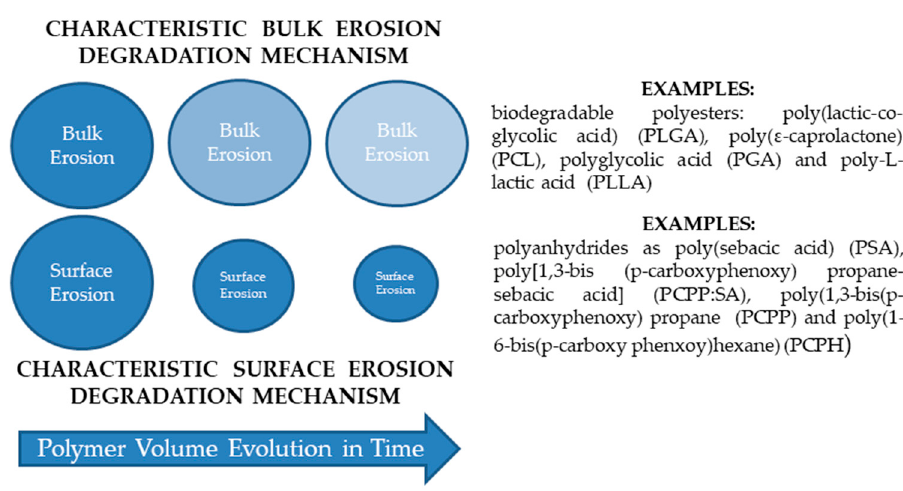
Figure 5. Schematic representation of evolution in time of surface erosion versus bulk erosion. Bulk degradation implies a faster degradation inside than at the surface of